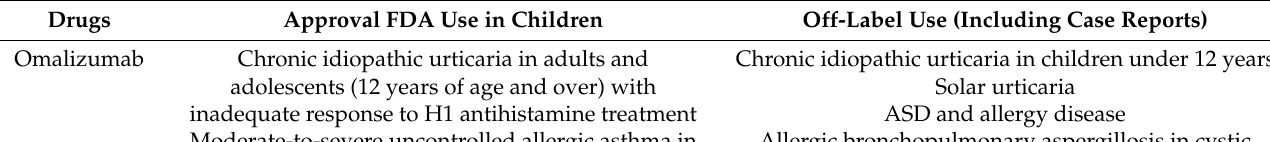
Table 1. Summary